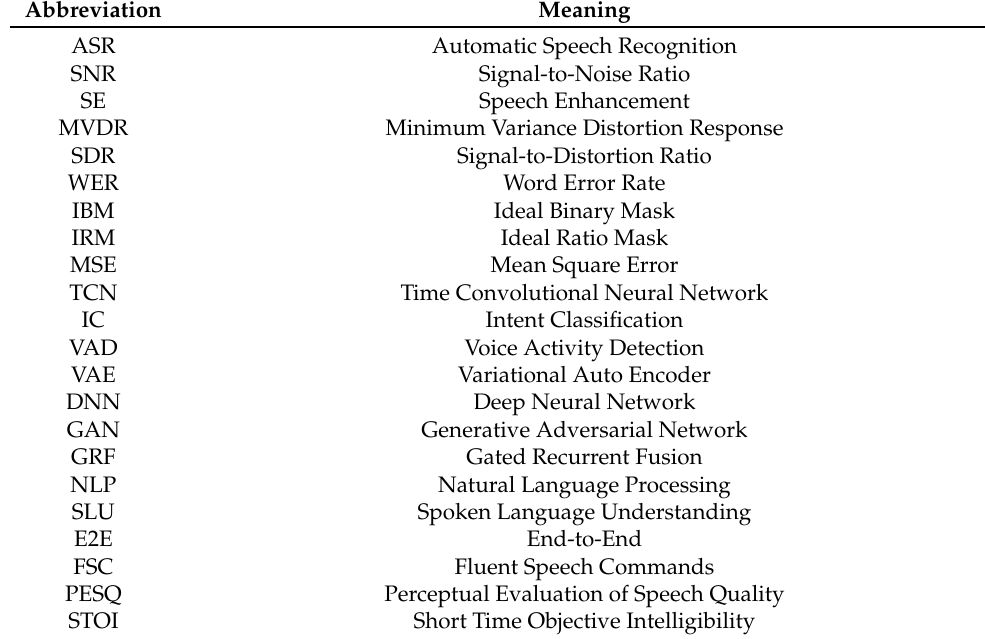
Table A1. List of